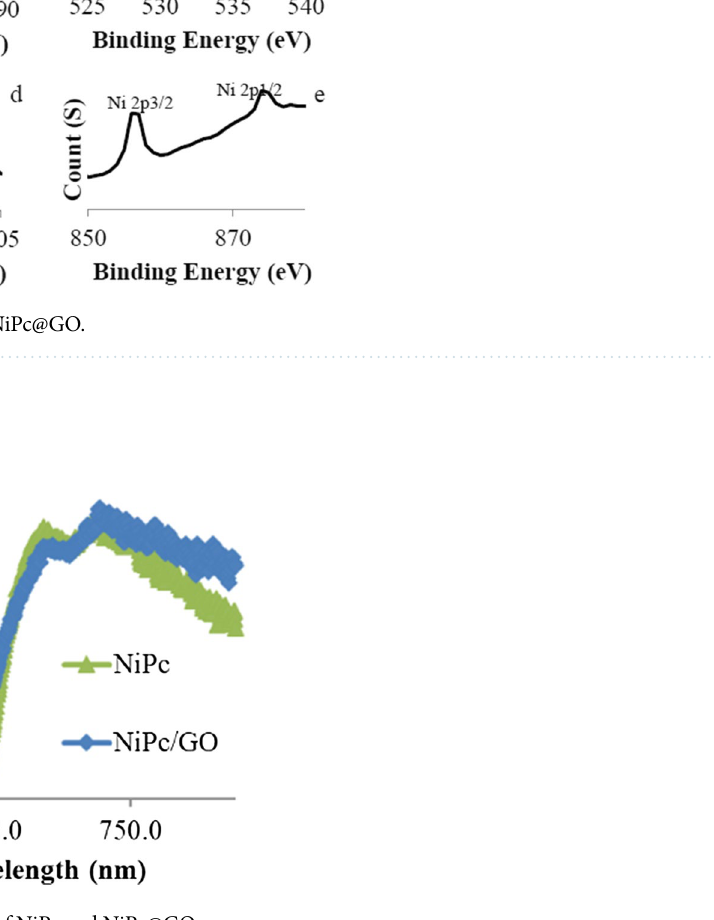
Figure 6. UV–Vis spectra of NiPc and